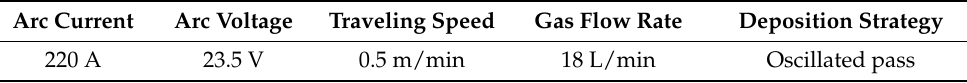
Table 1. WAAM processing parameters for the manufacturing of the SMSS wall.